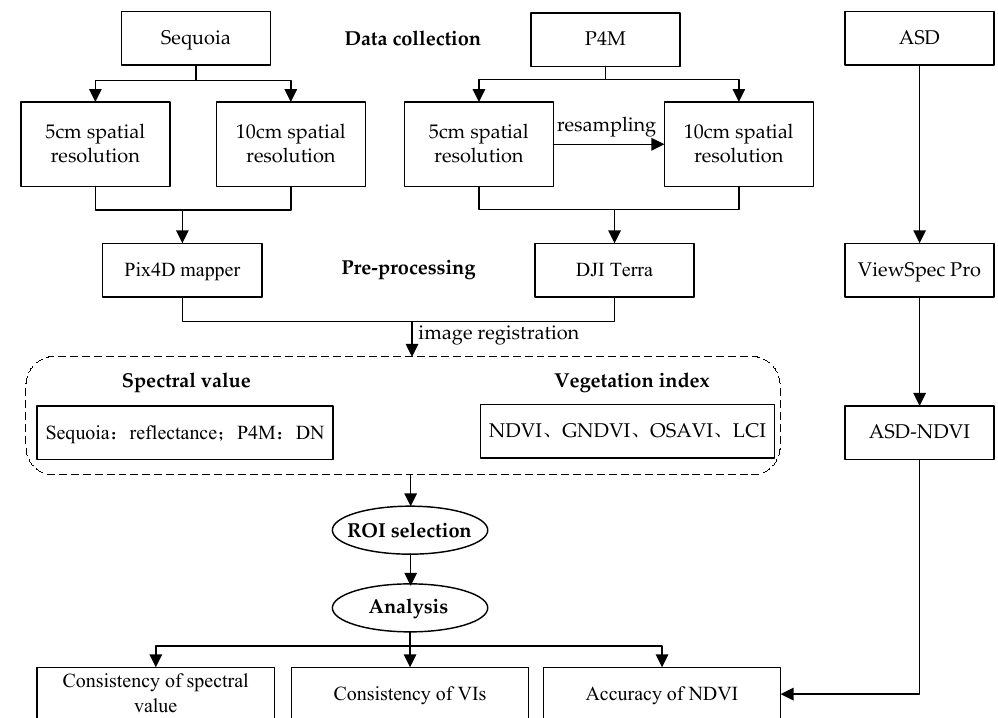
Figure 4. Methodological flowchart of the research.